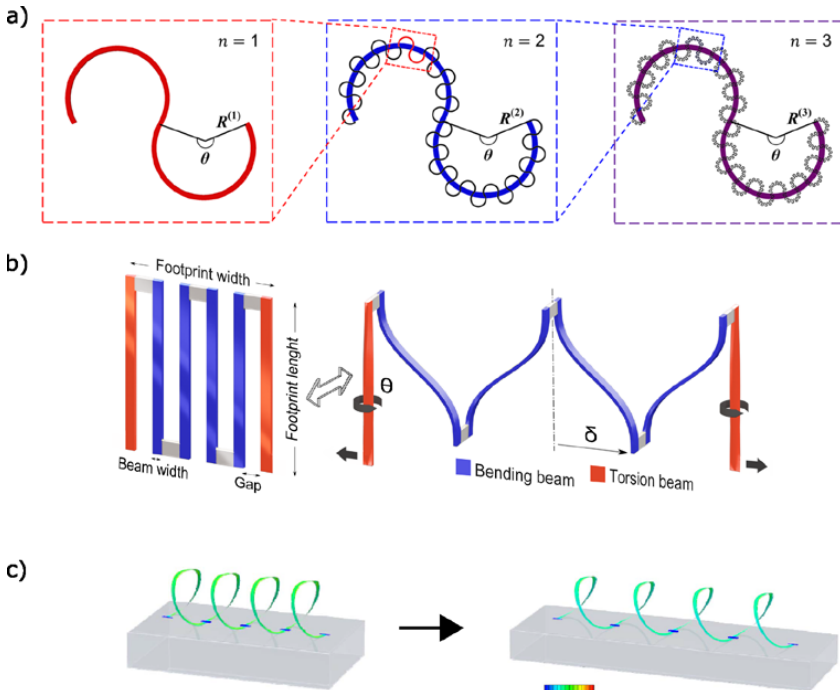
Figure 1. ( a ) typical horseshoe shape along with its higher order fractals ( b ) micro-scale patterned aluminum serpentine ( c ) helices showing gradual increase of built-in tension with mechanical loading. Adapted with permission from